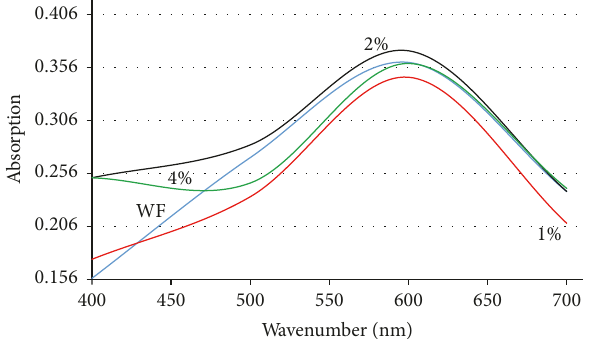
Figure 3: Spectral absorption of cookies after 2 days of storage. WF = wheat flour; 1% = 𝛽 -glucan added at 1% level to wheat flour cookies; 2% = 𝛽 -glucan added at 2% level to wheat flour cookies; 4% = 𝛽 -glucan added at 4% level to wheat flour